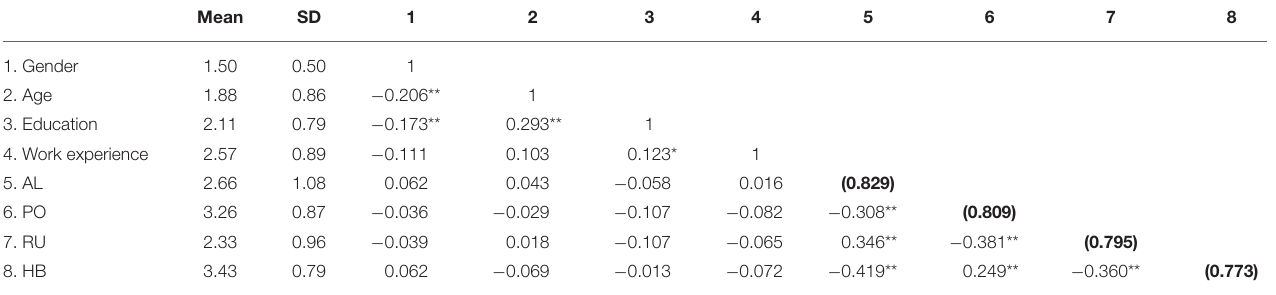
TABLE 2 | Descriptive